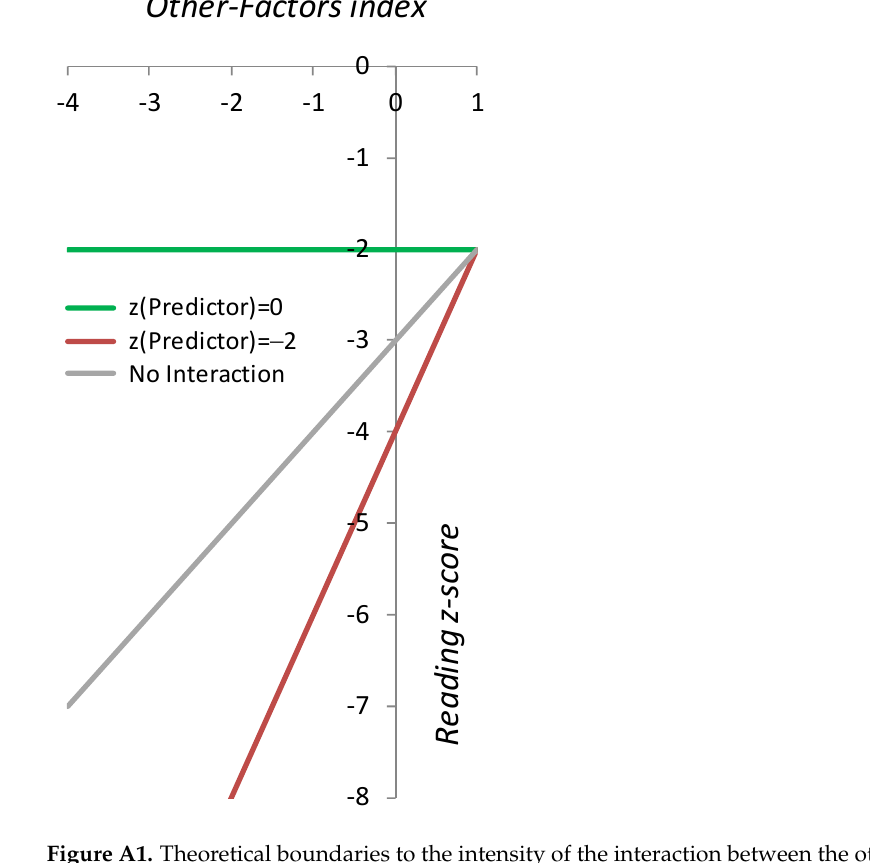
Figure A1. Theoretical boundaries to the intensity of the interaction between the other factors (OF) index, plotted on the horizontal axis, and the single-out predictor (green, z = 0, vs. red, z = − 2), on the reading z-score (vertical axis). The interaction, that is, the separation between the green and red slopes, should not be so large as to make the green slope negative, or the red slope higher than 2.